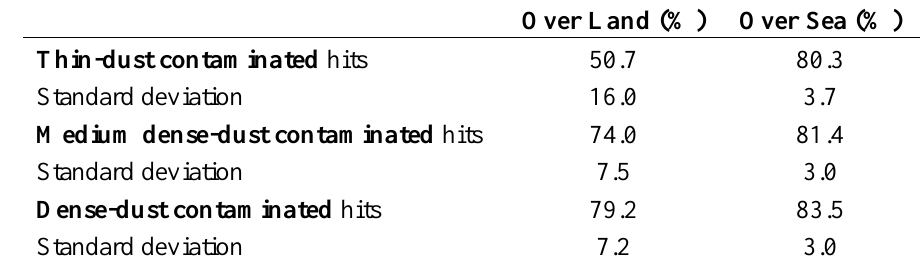
Table 4 . Performance of the MSG dust aerosol detection technique, obtained by comparisons with the MOD04/MYD04 product results listed in Table 3. Hits are considered when pixels detected as thin/medium/dense-contaminated by the MSG/SEVIRI dust detection tests are confirmed by the MOD04/MYD04 products. The performances are expressed in terms of the percentage of hits with respect to the total number of pixels. The standard deviation indicates the dispersion of the percentage hits over the batch of MODIS granules in Table 3.